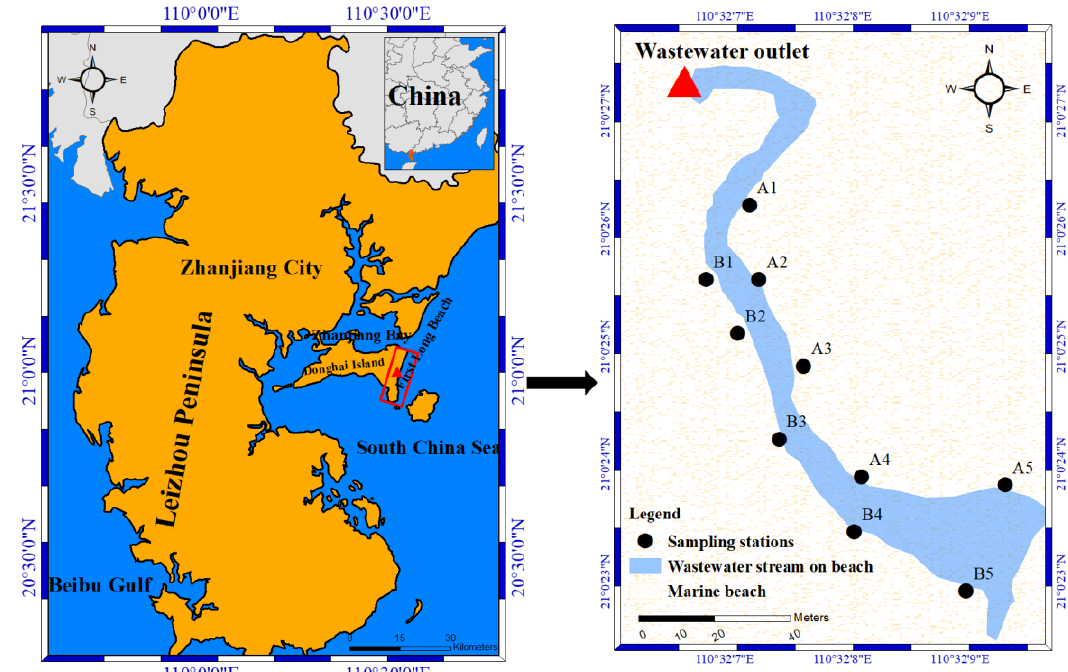
Figure 1. Geographical location of the First Long Beach (FLB) and marine sandy beach sampling stations along the land-based wastewater outlet.